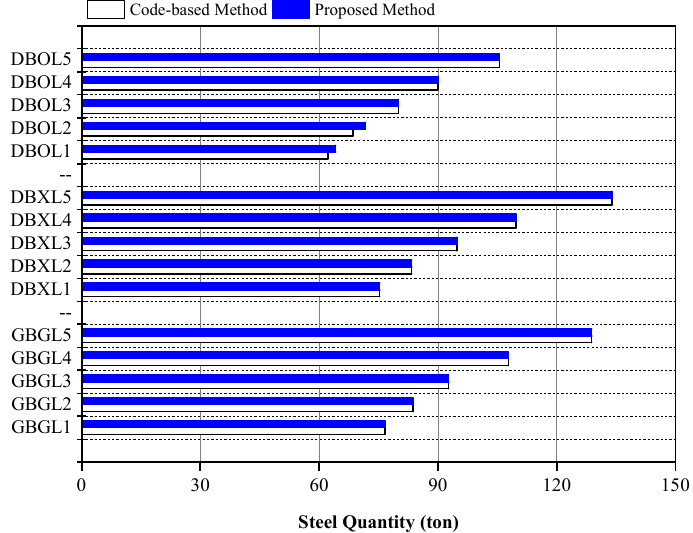
Figure 7. Designed steel quantity for each floor system from code-based and proposed methods.